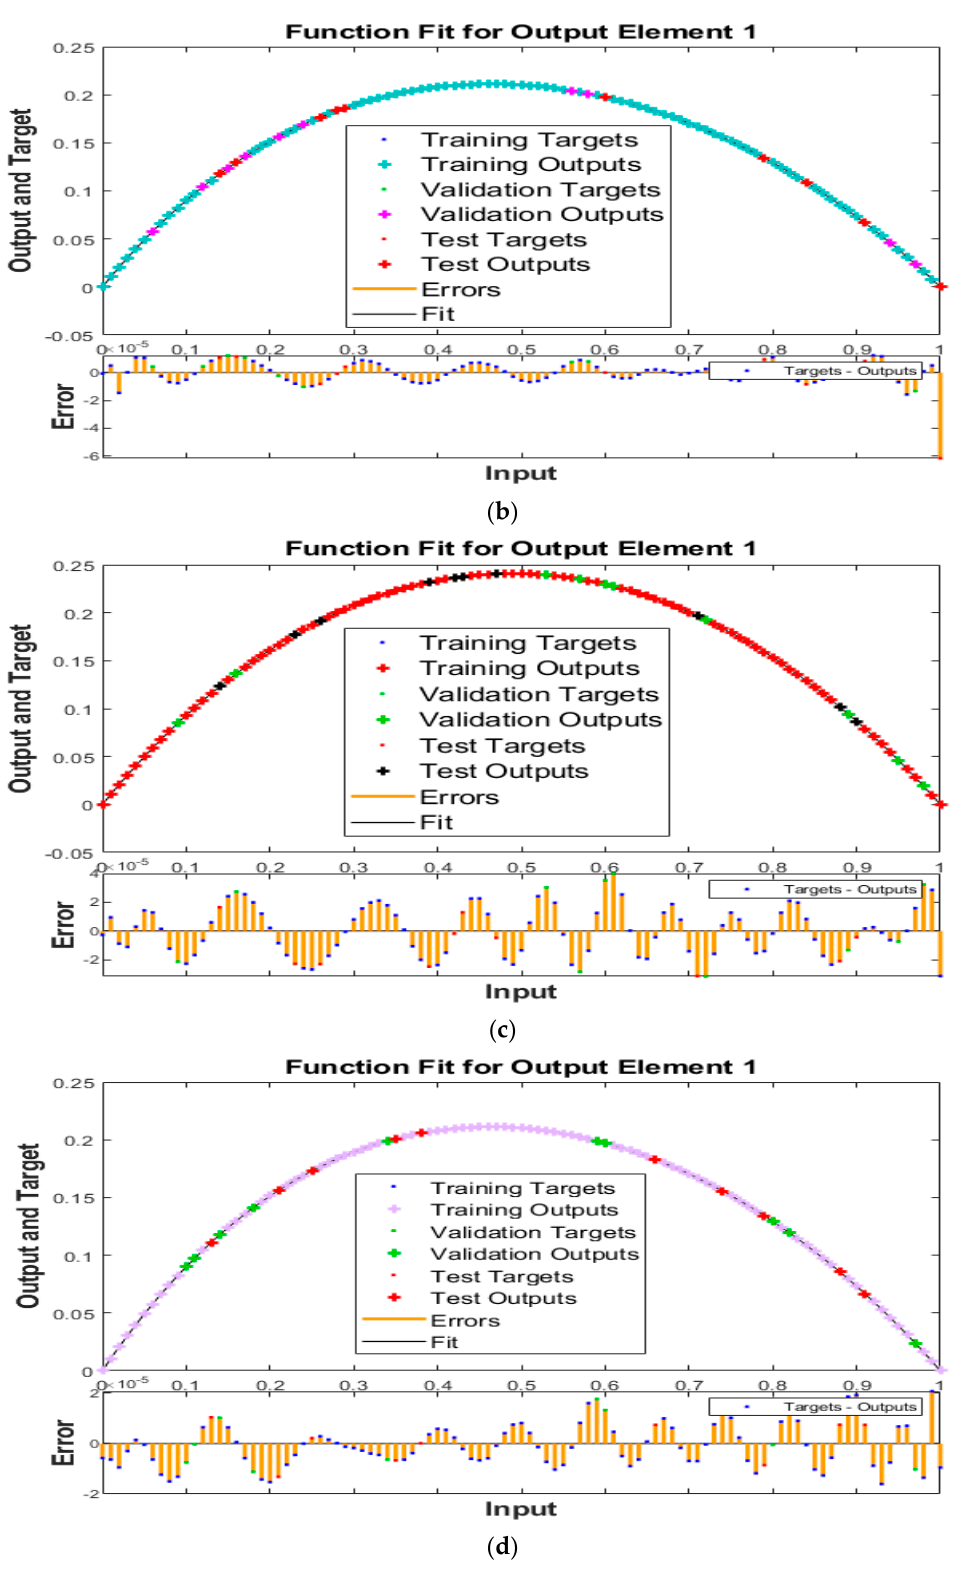
Figure 5. ( a – d ) ANNLMB outcome comparison from reference for different scenarios. ( a ) ANNLMB outcome comparison from reference for scenario 1; ( b ) ANNLMB outcome comparison from reference for scenario 1; ( c ) ANNLMB outcome comparison from reference for scenario 3; ( d ) ANNLMB outcome comparison from reference for scenario 4.